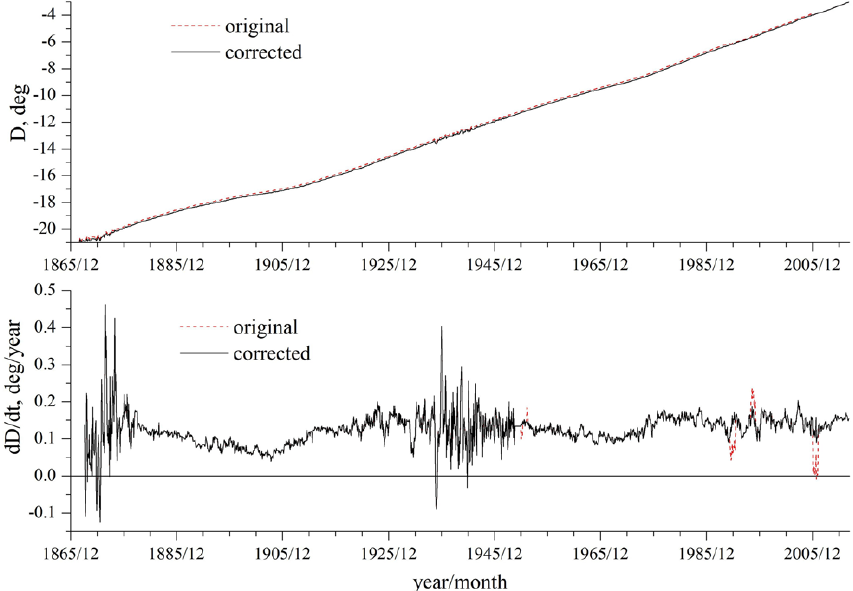
Fig. 8. Original (red dashed lines) and corrected (black solid lines) series of COI D (top panel) and its SV (bottom panel) from 1867 to